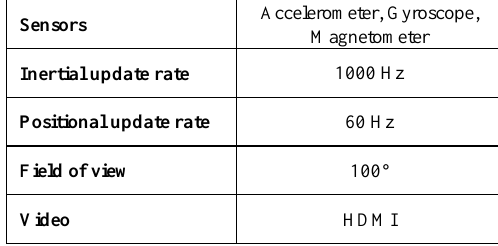
Table 2. The specifics of the Oculus